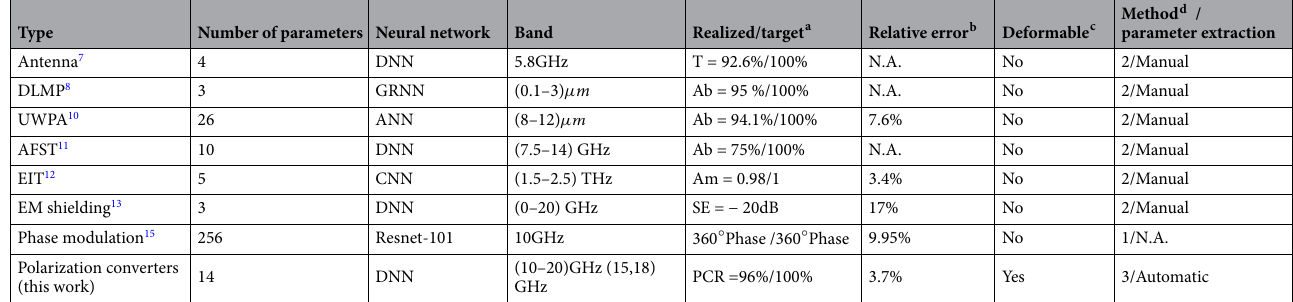
Table 6. Comparison of current work on metamaterial device designed by neural network. a T: transmittance. Ab: Absorption.Am: Amplitude.SE: Shielding effectiveness. b Relative error between predicted target and √ MSE / Range . c Deformable: the pattern is scalable, simulation results. Calculating Equation: Relative Error = rotatable, and shiftable. d 1: Pixel graph parameter extraction method. 2: Manual parameter extraction method. 3: Vectorgraph parameter extraction